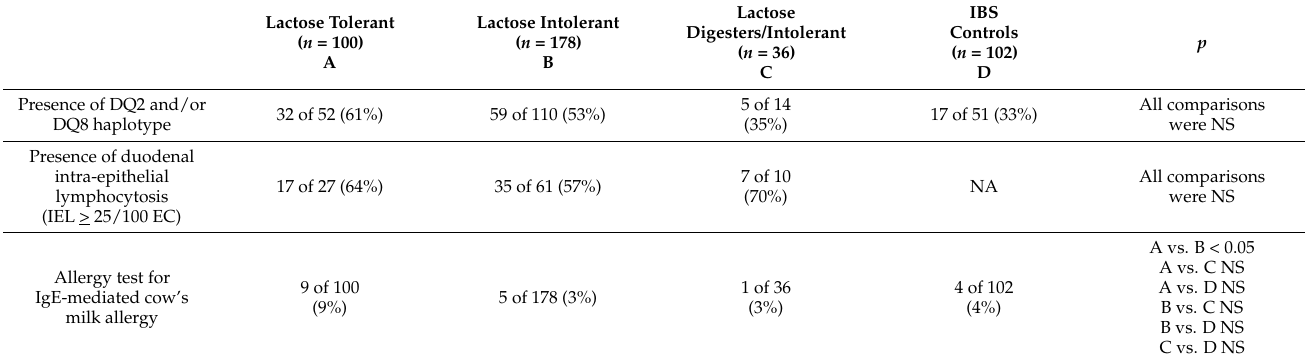
Table 2. Frequency of the HLA DQ2 and DQ8 haplotypes, of intra-epithelial lymphocytosis in the duodenal mucosa, and of allergy test for IgE-mediated cow’s milk allergy in the 314 study subjects, grouped according to the LHBT results as “Lactose tolerant”, “Lactose intolerant”, and “Lactose digesters/intolerant”, and in the IBS controls who did not report milk